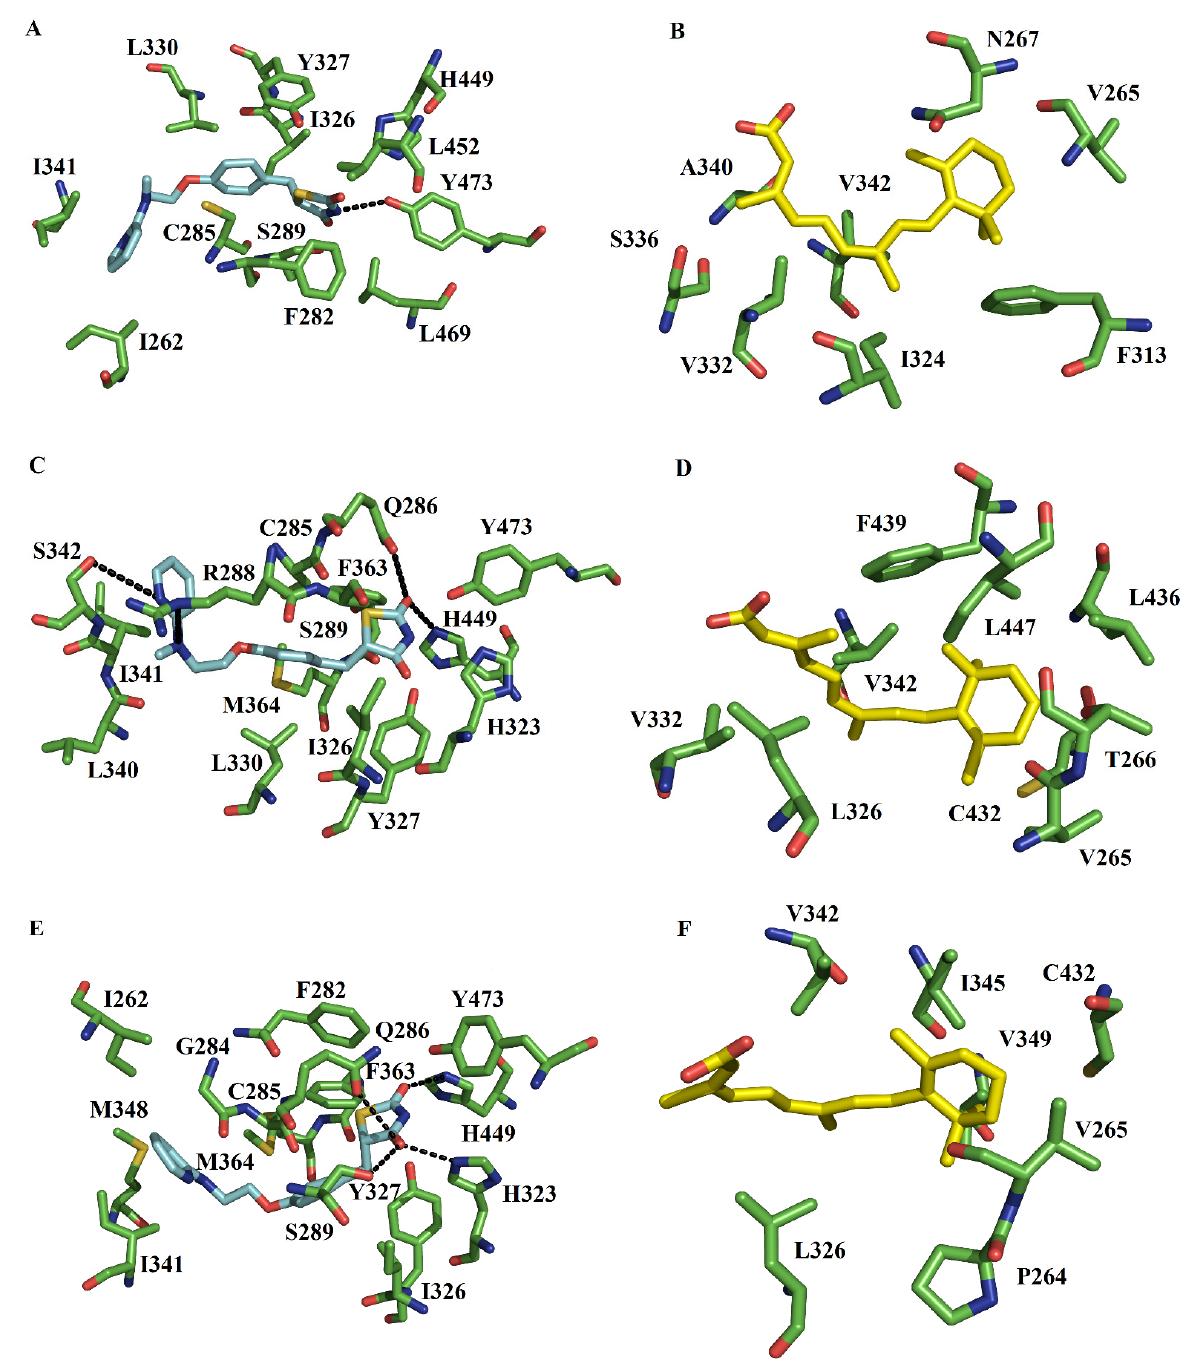
Figure 3. Map of interactions of RGZ and 9CR in the PPAR γ -RXR α system. Interactions of RGZ and 9CR at the ligand-binding site of PPAR γ and RXR α , respectively, are present in the first [RGZ ( A ) and 9CR ( B )], second [RGZ ( C ) and 9CR ( D )], and third [RGZ ( E ) and 9CR ( F )] most populated conformations.